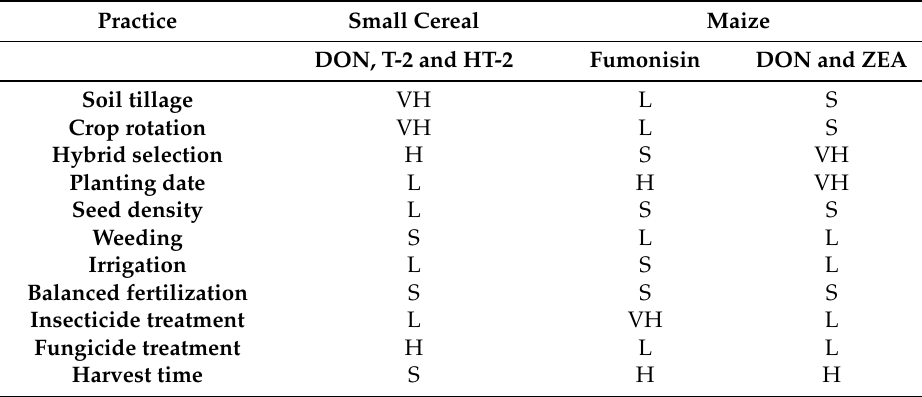
Table 7. Importance of GAPs for mycotoxins